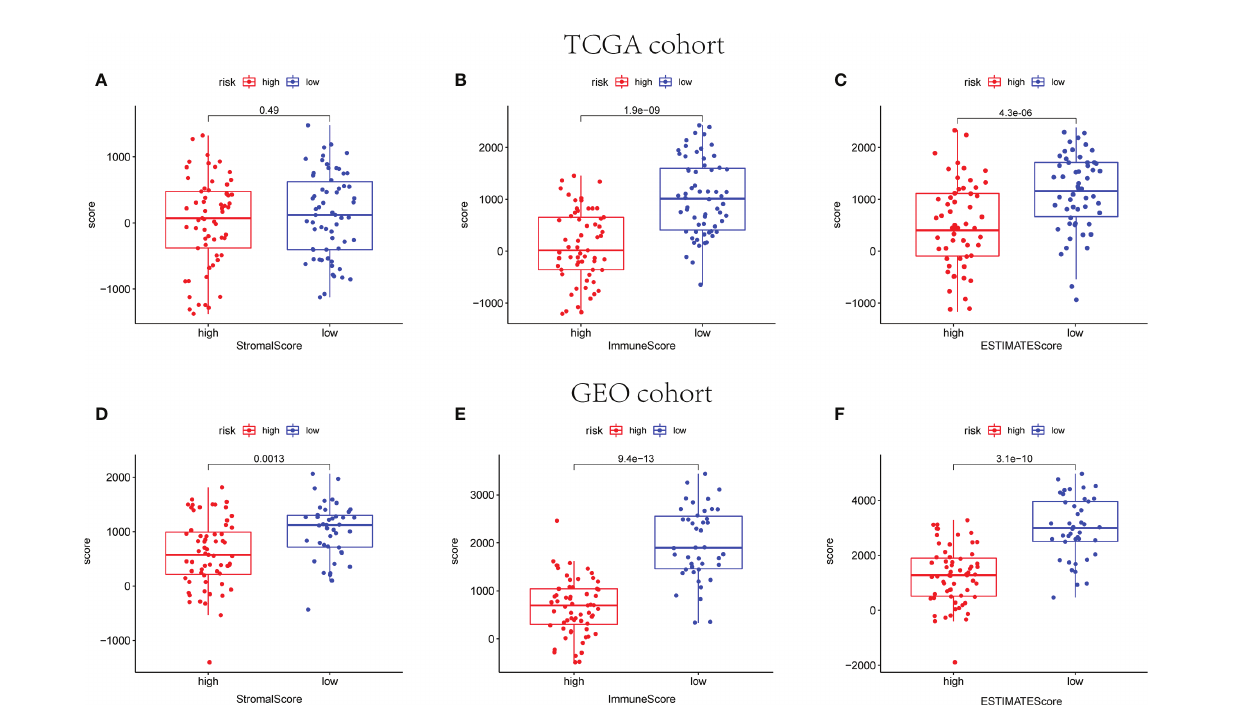
FIGURE 9 | The scatter plot shows that the stromal scores, the immune scores, and the ESTIMATE scores are distributed differently between different risk groups in TCGA (A – C) and GEO cohorts (D – F)